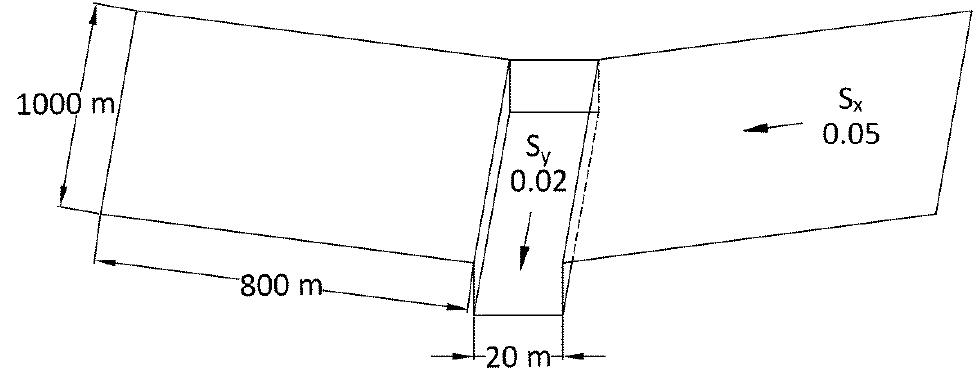
Figure 5. Domain schematization for the V-shaped test case.